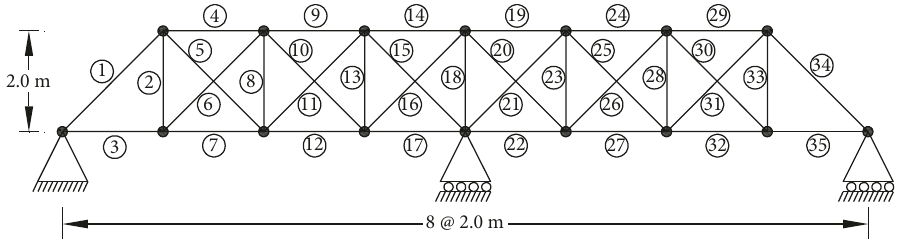
Figure 5: 35-element planar truss.